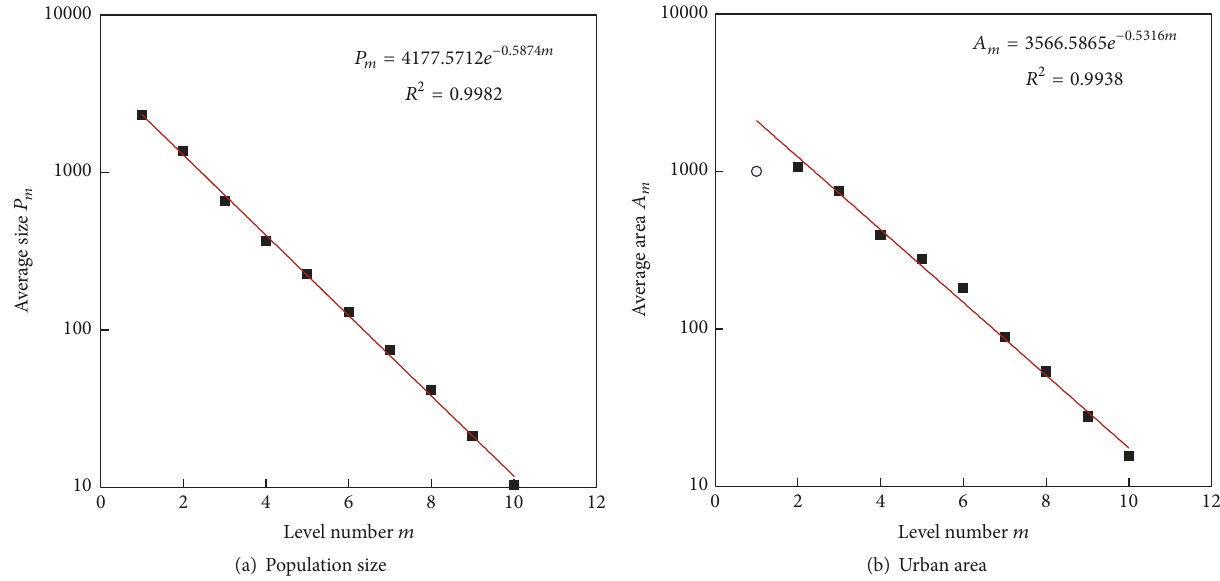
Figure 4: The patterns of exponential decay of population size and built-up area of Chinese cities in 2010. [ Note . The small circle represents the outlier indicating the top-level